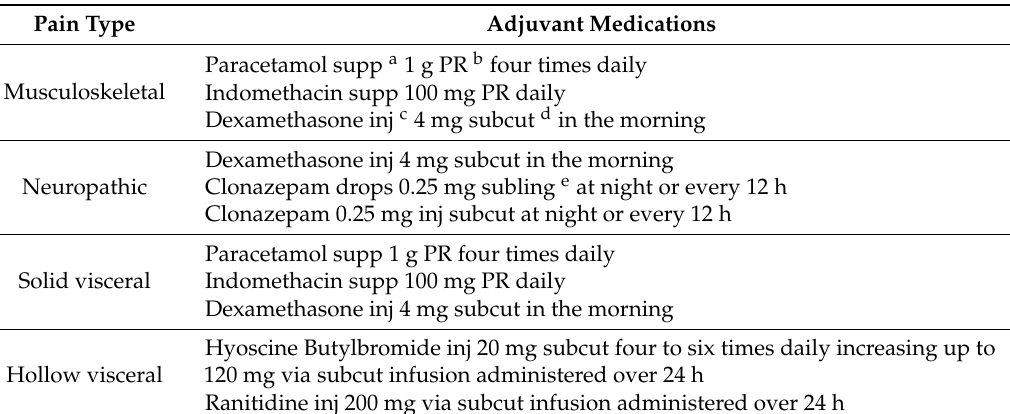
Table 1. Adjuvant analgesia at the end-of-life